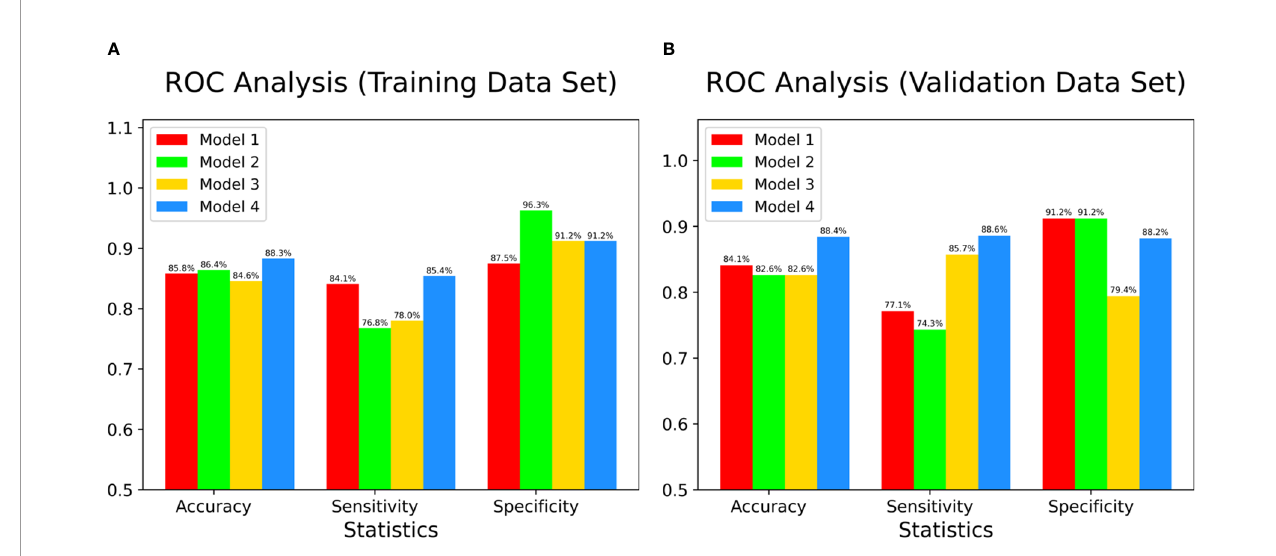
FIGURE 4 | The accuracy, sensitivity, and speci fi city of four models in both training data set (A) and validation data set (B) . Color bars indicate radiomics